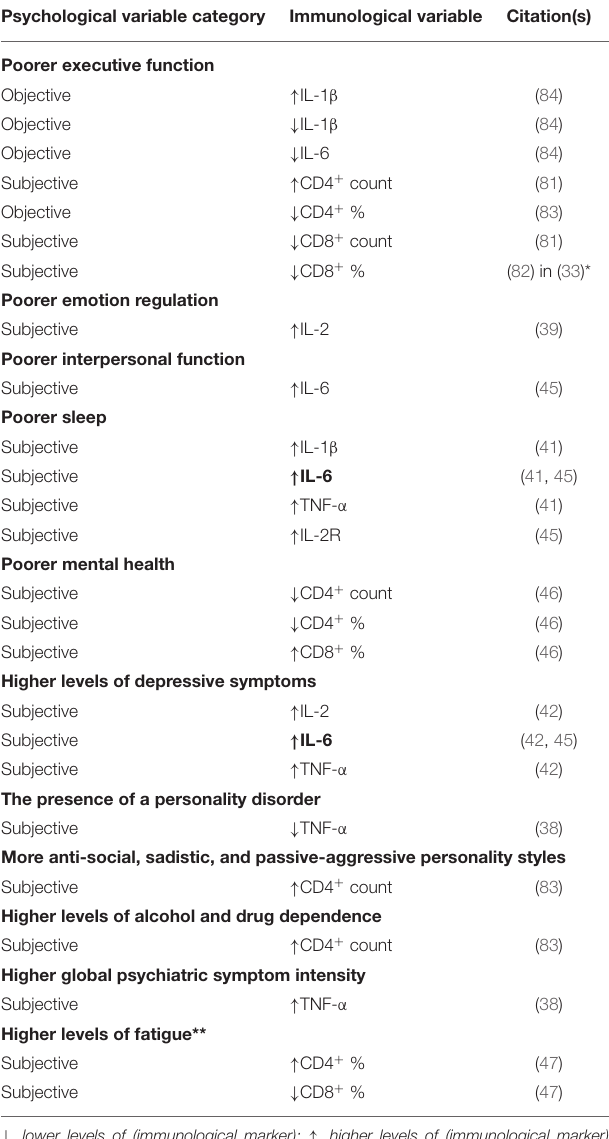
TABLE 3 | The directions of the significant, cross-sectional associations between psychological and immunological variables in CFS/ME. Psychological variable category Immunological variable